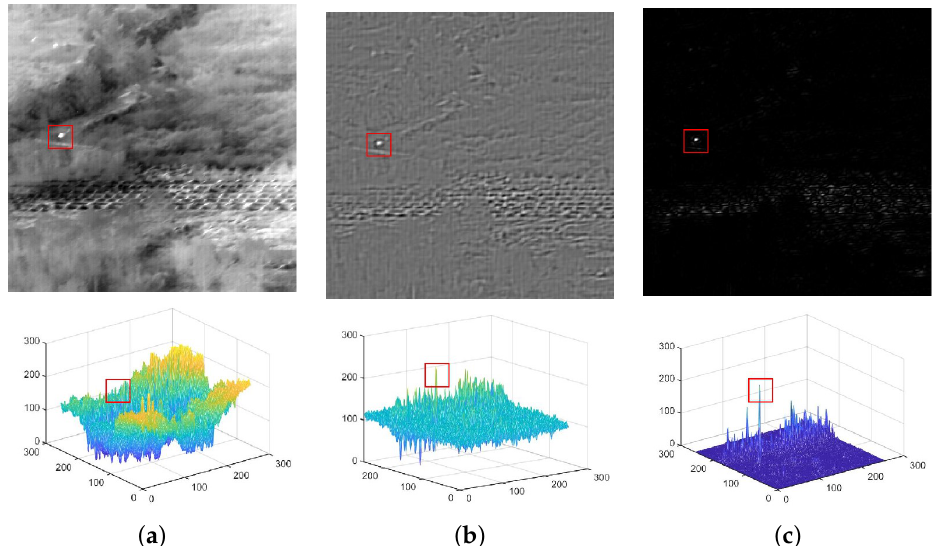
Figure 3. Target enhancement process. ( a ) original image; ( b ) result of facet kernel filtering; ( c ) result of square calculation. Red boxes indicate the